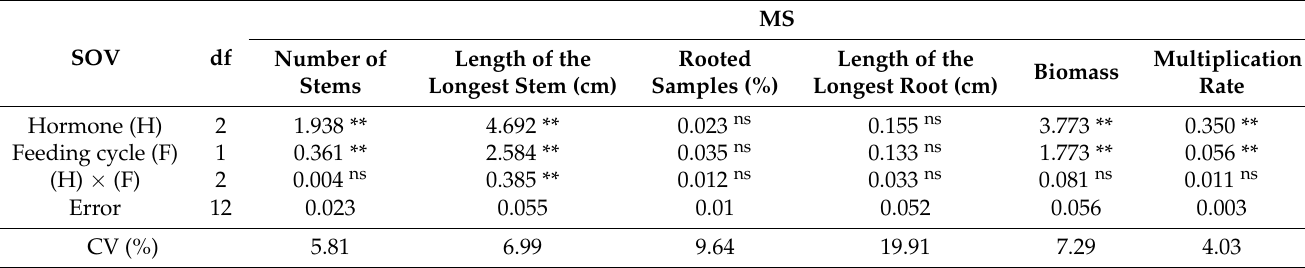
Figure 7. The effect of the plant growth hormones on the number of stems ( A ), biomass ( B ), and multiplication rate ( C ) of S. pennata seedlings via micropropagation technique in a solid culture medium. Bars with a common letter are not significantly different from each other. p < 0.05 probability level (Duncan’s test). Table 3. Analysis of variance of the plant growth hormone effect and the number of feeding cycles in the TIB system on S. pennata seedling growth